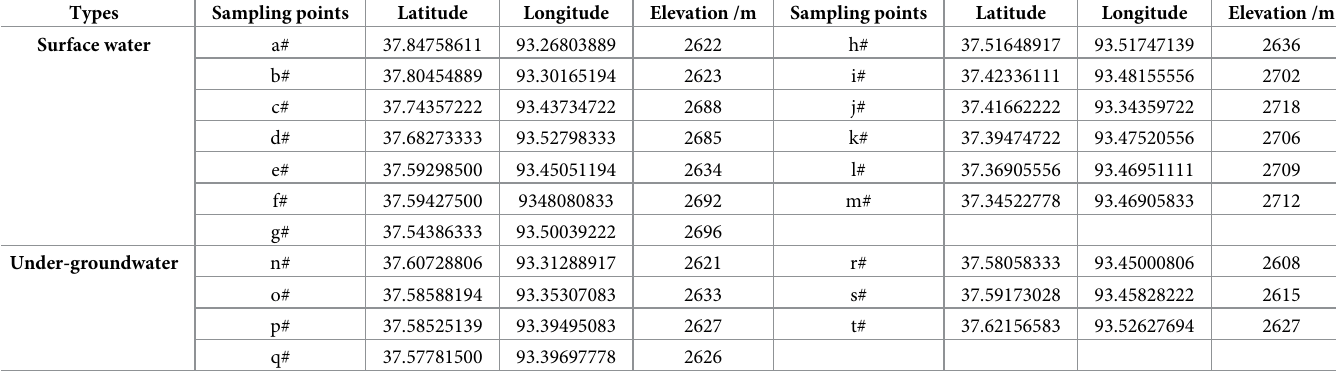
Table 1. Geographic coordinates and elevation for the data